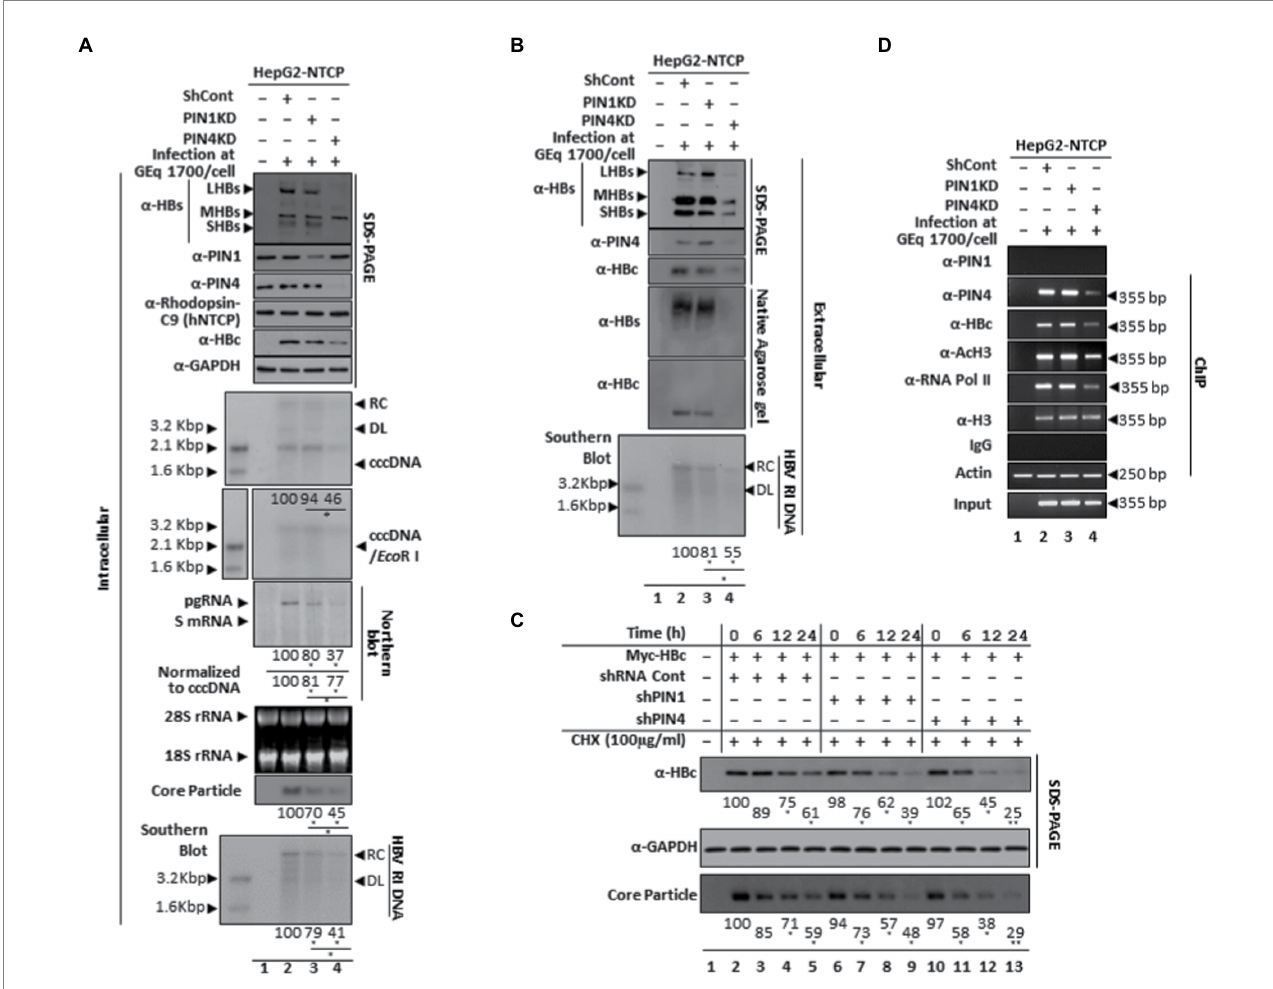
FIGURE 11 In comparison with PIN1 KD, PIN4 KD further reduced intracellular HBV replication and extracellular virion release and extracellular HBV DNA levels in HBV- infected cells. (A) Intracellular HBV replication decreases by PIN1 and PIN4 knockdown. HepG2-hNTCP-C9 (lane 1), HepG2-hNTCP-C9 Sh Cont (lane 2), HepG2-hNTCP-C9-PIN1 KD cells (lane 3), or HepG2-hNTCP-C9-PIN4 KD cells (lane 4) were seeded and mock-infected (lane 1) or HBV infected (lanes 2–3), as described previously (Saeed et al., 2019, 2021). Intracellular lysates were subjected to SDS-PAGE (13.5%) and NAGE immunoblotting, Northern, and Southern blotting. Hirt extraction methods were adopted to examine levels of cccDNA levels in PIN1 KD or PIN4 KD cells. (B) Extracellular HBV virion secretion was restricted upon PIN1 or PIN4 knockdown. The HBV virions, naked core particles, HBs subviral particles obtained from